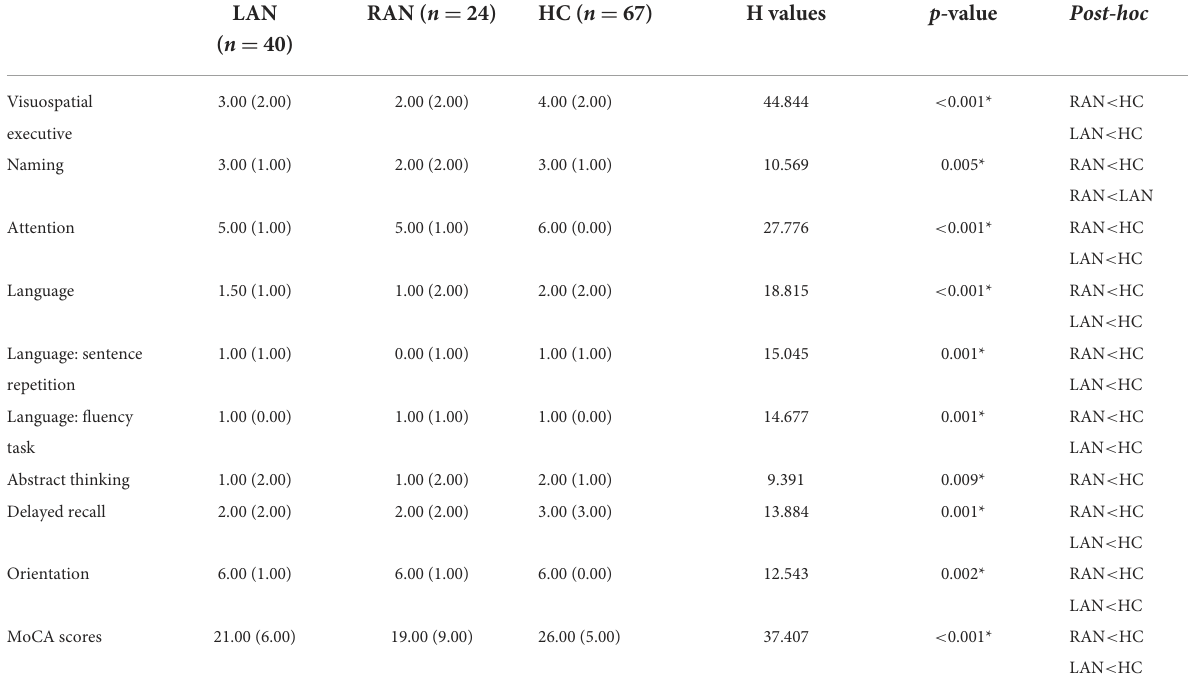
TABLE 2 Comparison of MoCA among LAN, RAN, and HC groups.